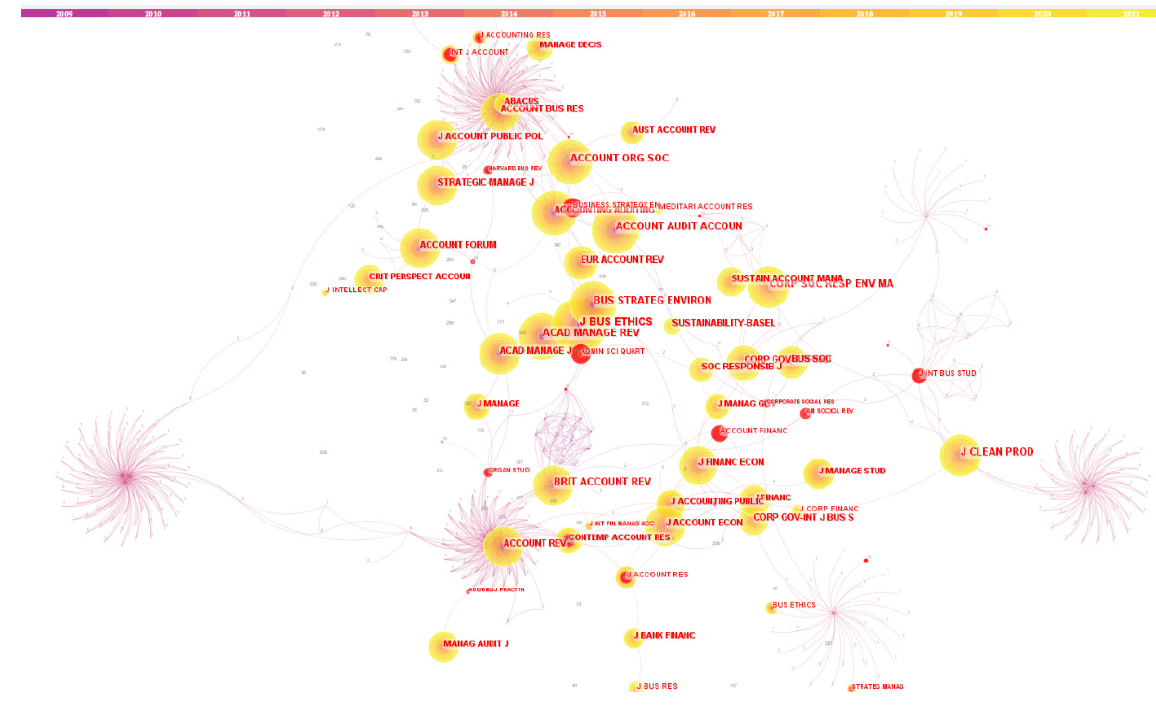
Figure 4. Co-cited